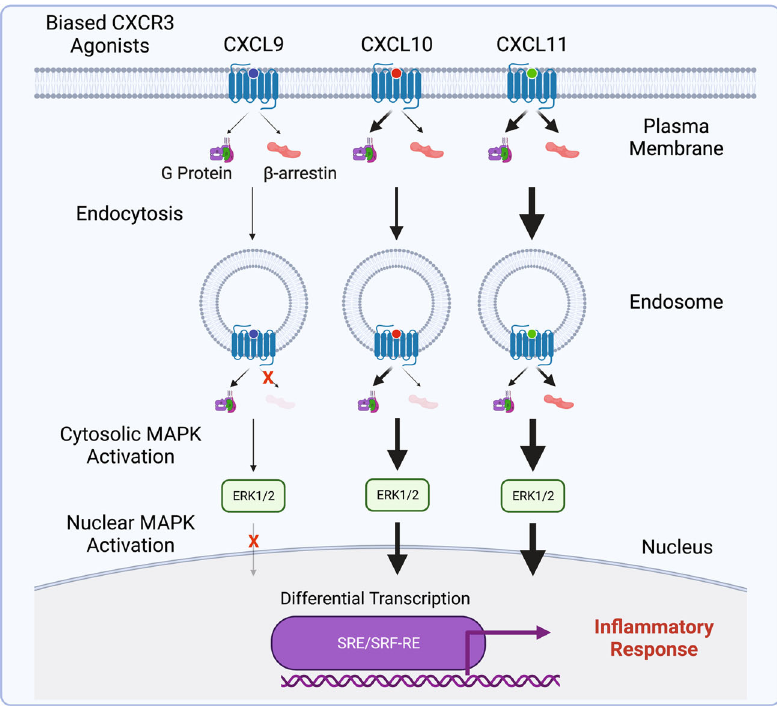
Fig. 7 | Working model of biased subcellular signaling at CXCR3. The three endogenous CXCR3 chemokines demonstrate unique patterns of signaling at the plasma membrane and endosome, resulting in location bias. Biased